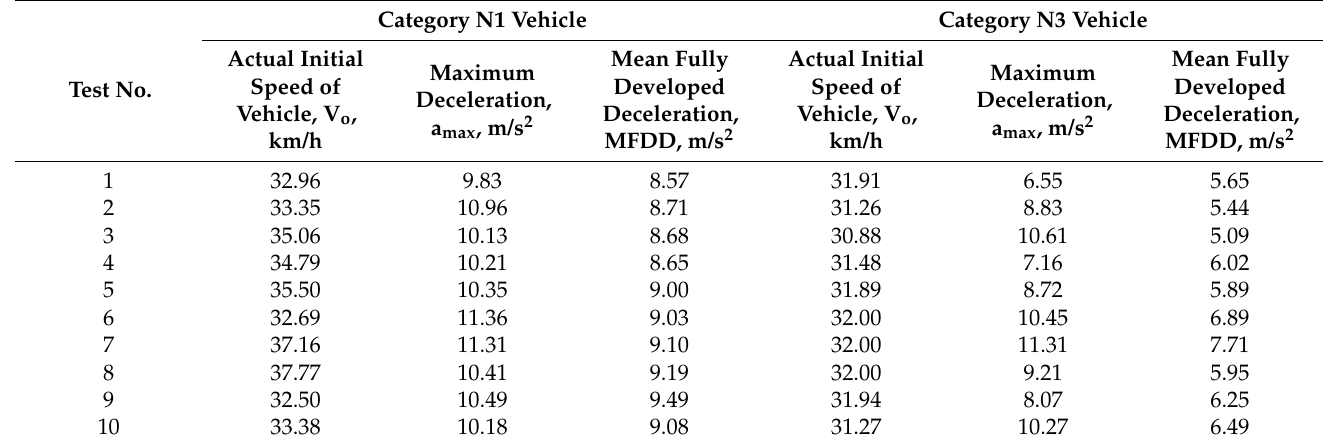
Table 1. Parameters of the braking process on a dry asphalt pavement from 30 km/h.